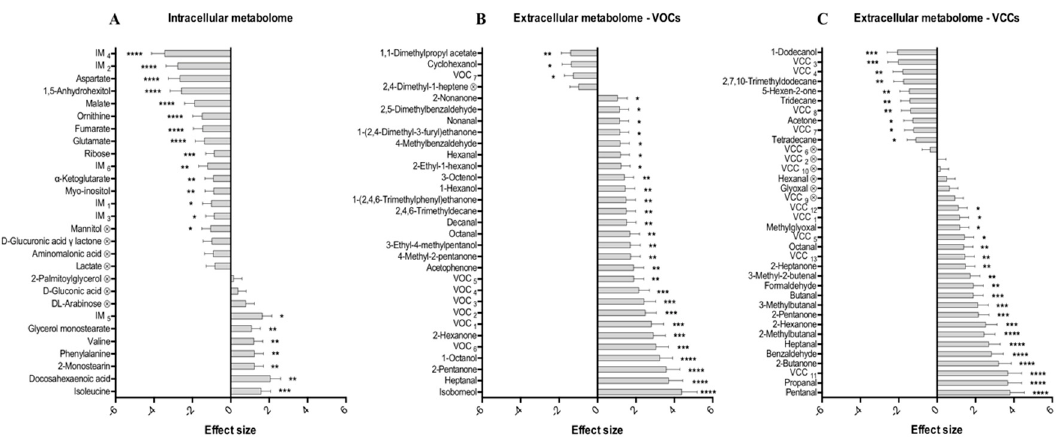
Figure 3. Effect size of the metabolites altered by heat stress, evaluated by comparison of cells exposed to hyperthermic vs. normothermic conditions in the ( A ) intracellular metabolome and ( B and C ) extracellular metabolome (VOCs and VCCs, respectively). Unidentified compounds are reported as ‘IM i ’, ‘VOC i ’ and ‘VCC i ’ (i = 1, 2, 3...) according to the ascending order of their retention time (RT) values. Metabolites marked with ⊗ are not statistically significant after false discovery rate (FDR) correction (FDR corrected p -value: 3.93 × 10 − 2 for intracellular metabolome, 4.84 × 10 − 2 for VOCs, and 4.12 × 10 − 2 for VCCs). * p < 5.00 × 10 − 2 , ** p < 1.00 × 10 − 2 , *** p < 1.00 × 10 − 3 , **** p < 1.00 × 10 − 4 (hyperthermic vs. normothermic conditions).